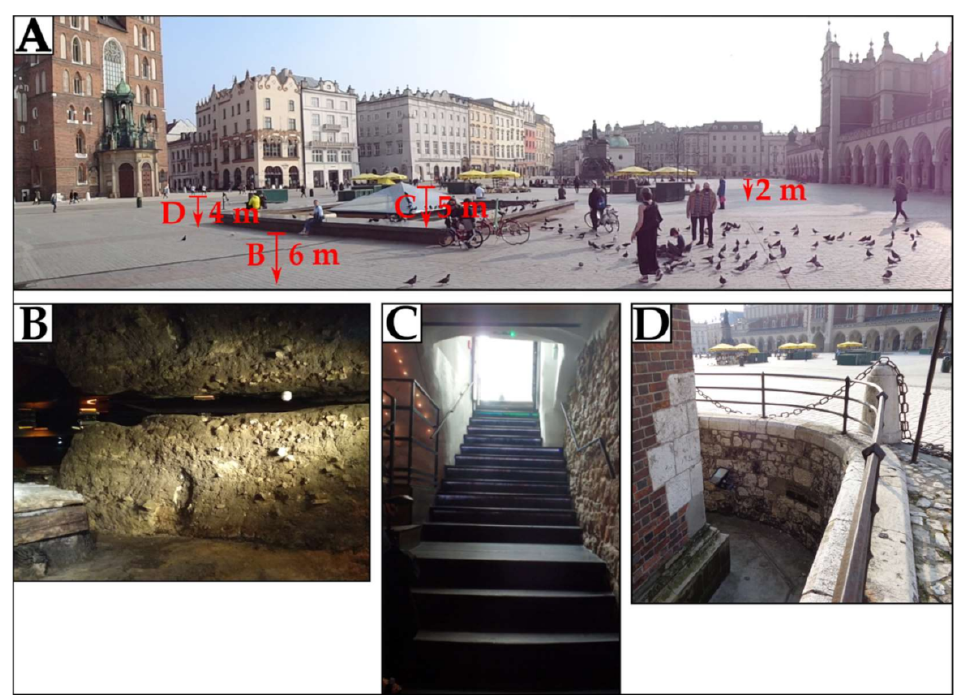
Figure 11. Morphology of the slopes of Lasota Hill transformed as a result of limestone quarrying. ( A )—vertical rocky walls adjacent to slopes of initial morphology; ( B )—excavation floor in the closed quarry adjacent to rocky walls. March 2021. Photos by R. Zarychta.